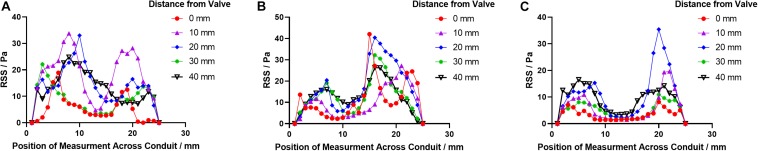
The RSS profile distributions downstream the leaflets in (A) PB1, (B) PB2, and (C) PT at t2.